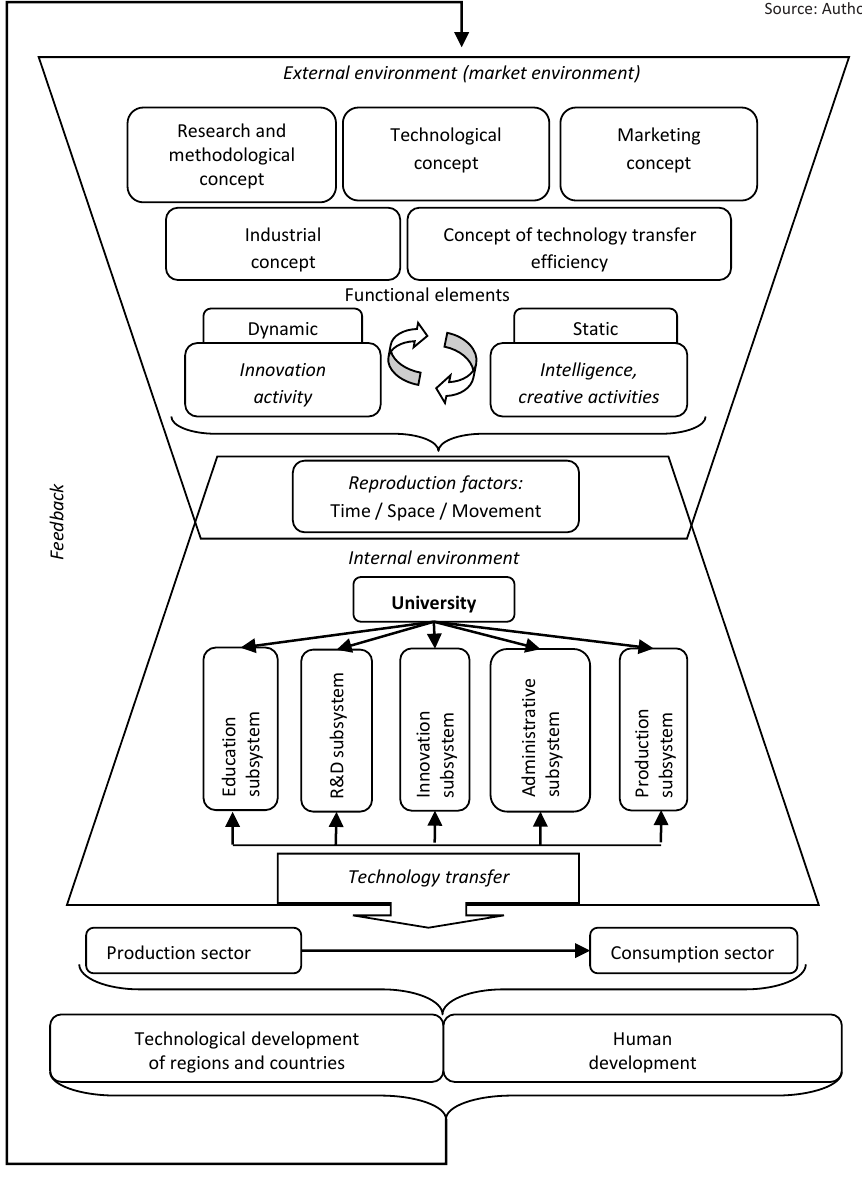
Figure 5. Conceptual approach to understanding of technology